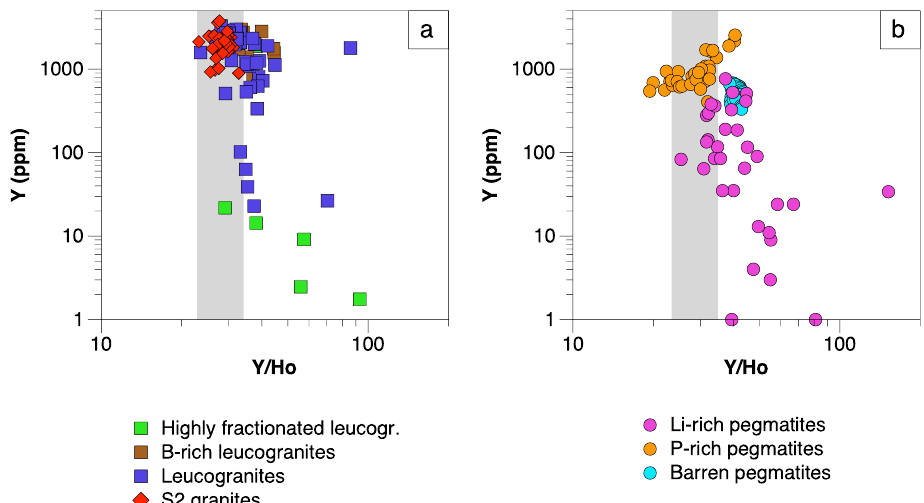
Figure 11. Binary plot of Y/Ho versus Y in apatite from ( a ) granitic; and ( b ) pegmatitic lithologies. The greyish area represents the region where Y/Ho ratios correspond to CHARAC values.